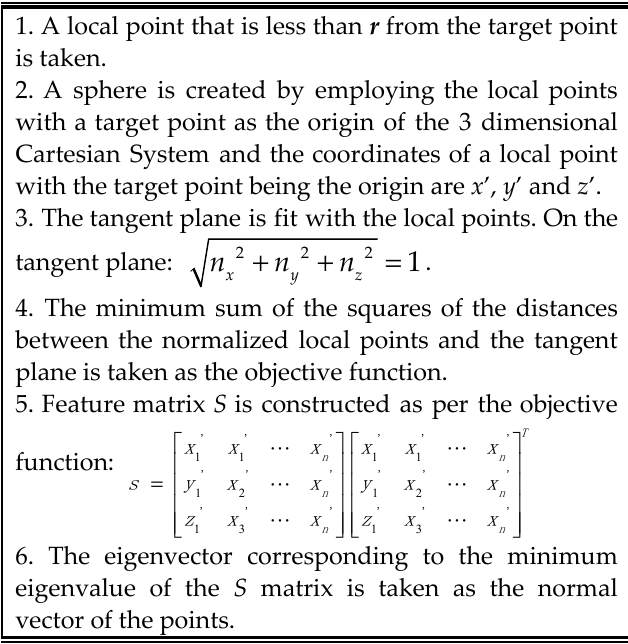
Figure 5. The PCA method to estimate the target point normal vector.